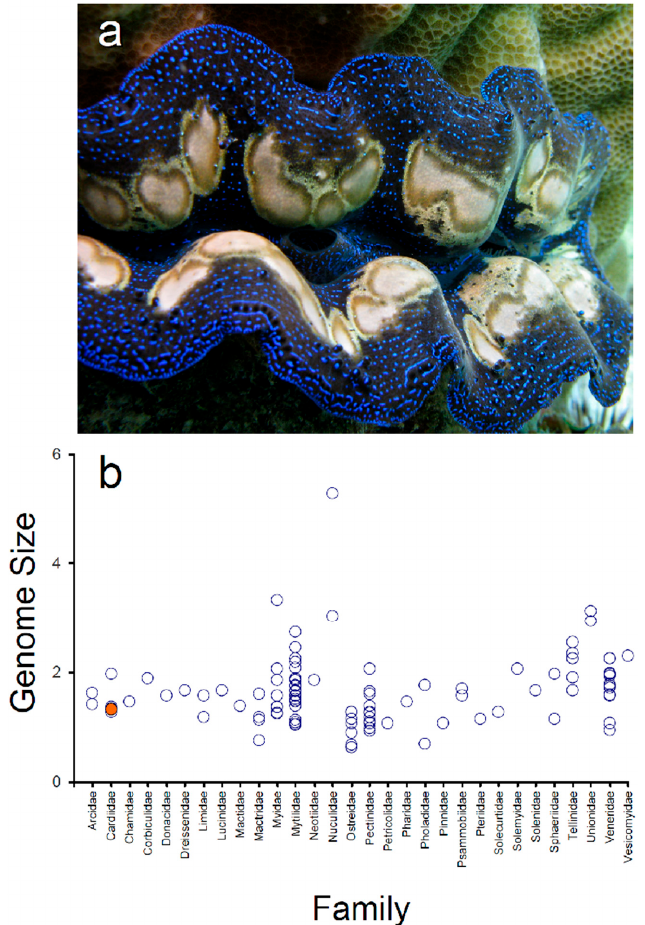
Figure 1. Genome size estimation (Gigabases) using a k-mer approach in the boring giant clam Tridacna crocea (orange dot) ( a ) and genome size estimated for other species belonging to different families in the class Bivalvia (open circles) ( b ). Genome size data from other bivalves retrieved from www.genomesize.com. The top photograph depicts a specimen of T. crocea with a blue mantle color pattern (photo credit: J. Antonio Baeza).